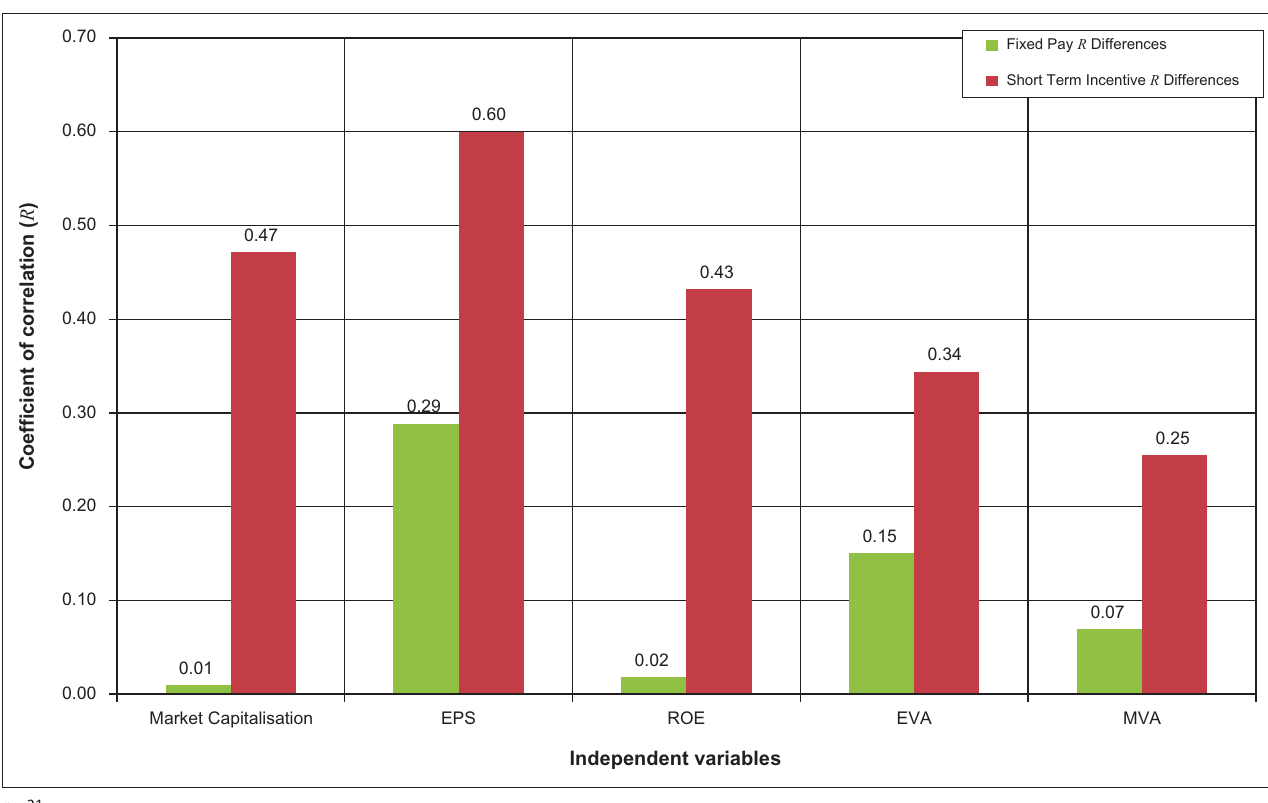
FIGURE 10: Means and medians correlation coefficients ( R )